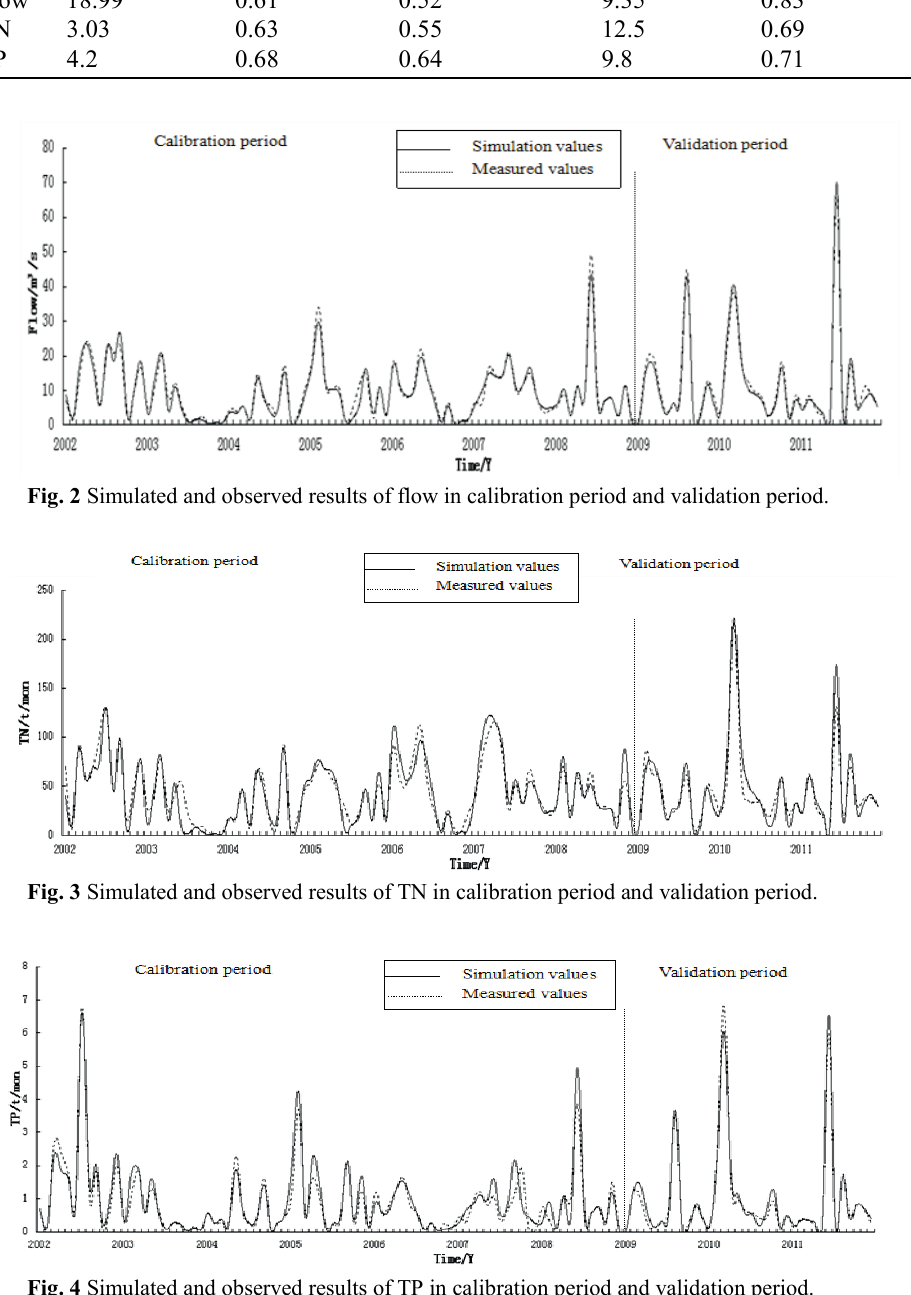
Fig. 4 Simulated and observed results of TP in calibration period and validation